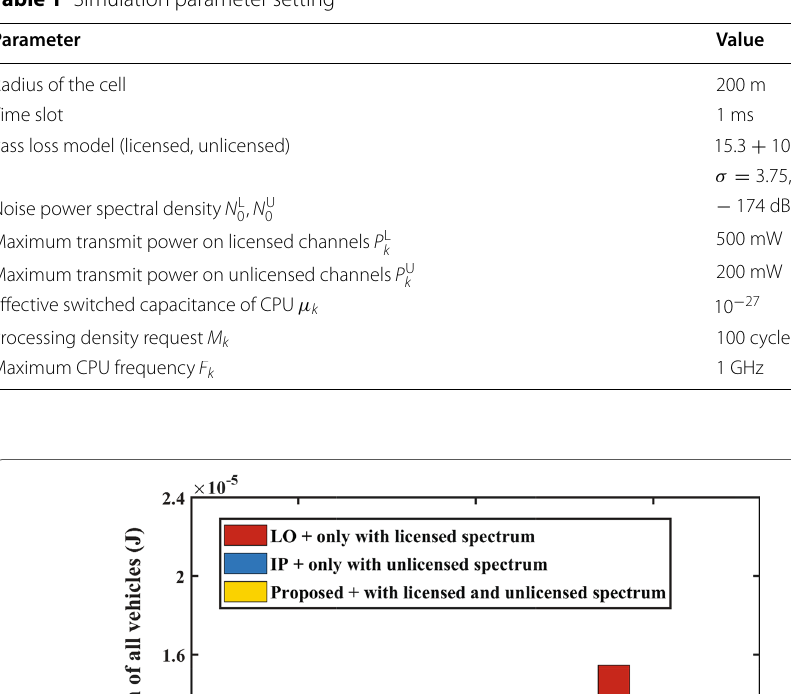
Table 1 Simulation parameter setting